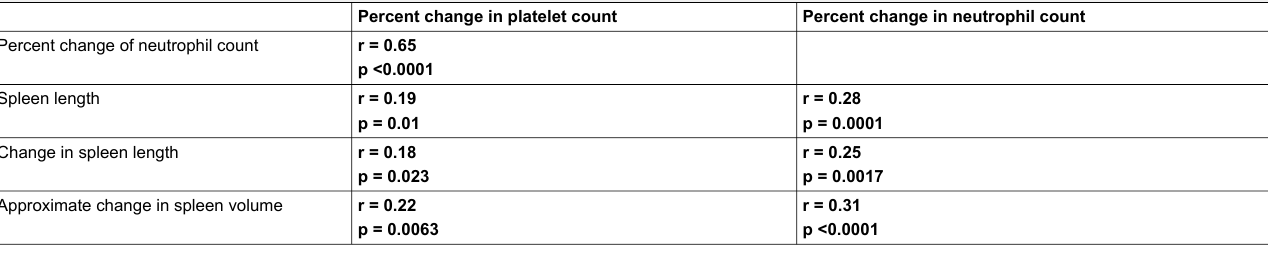
Table 2: Correlation analysis of percent changes in platelet, neutrophil and spleen parameters. Significant differences are indicated in green (p <0.05), very significant differences in red (p <0.01); Spearman's rank correlation test.